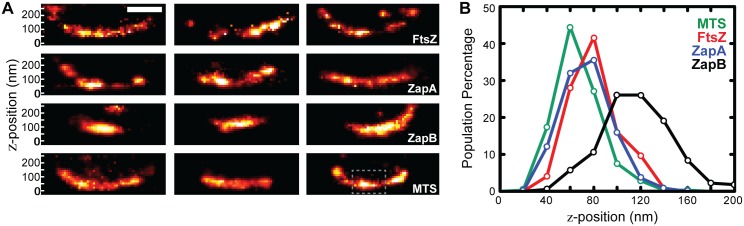
iPALM imaging and z-position measurements of FtsZ, ZapA, and ZapB.(A) Cross-sectional views of the midcell region of representative wt cells expressing FtsZ-mEos2, mEos2-ZapA, ZapB-mEos2 or mEos2-MTSBs (three cells for each strain) are displayed in respective rows. All images are to scale and share the same z-dimensions as labeled on the left. The dashed rectangle box (gray) in the bottom right-most image is representative of the user-defined box we used to calculate mean z-positions. (B) Histograms (20 nm bins) of the average measured z-positions for each protein structure in individual cells illustrate the internal nature of ZapB. Scale Bar, 250 nm.